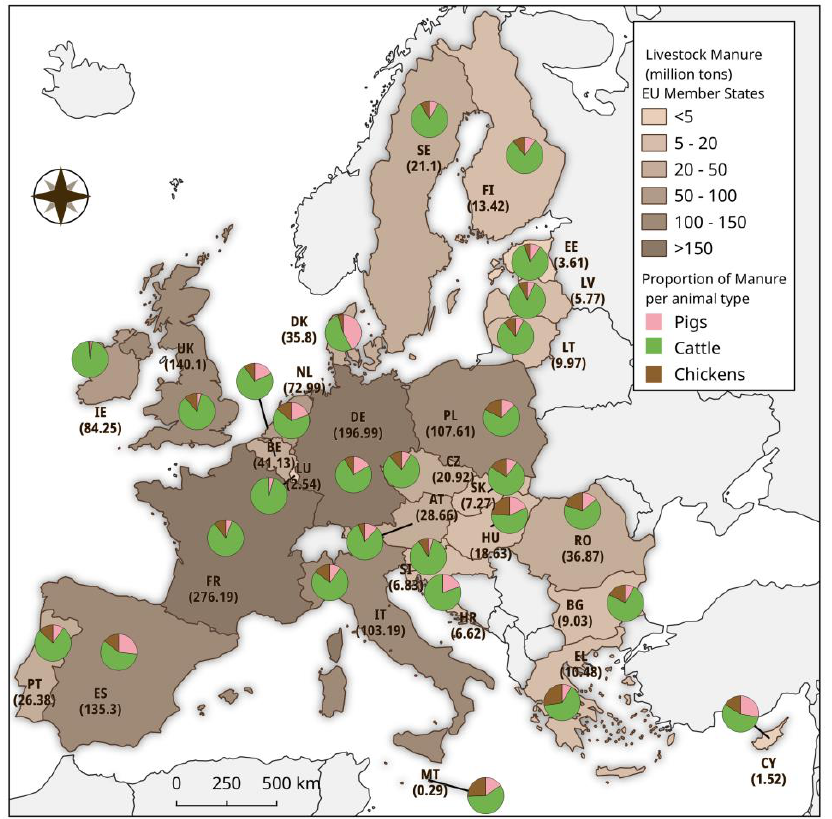
Figure 9. Annual manure production (million tonnes) in the European Union and UK and distribution according to main animal types (period: 2016–2019) [74].